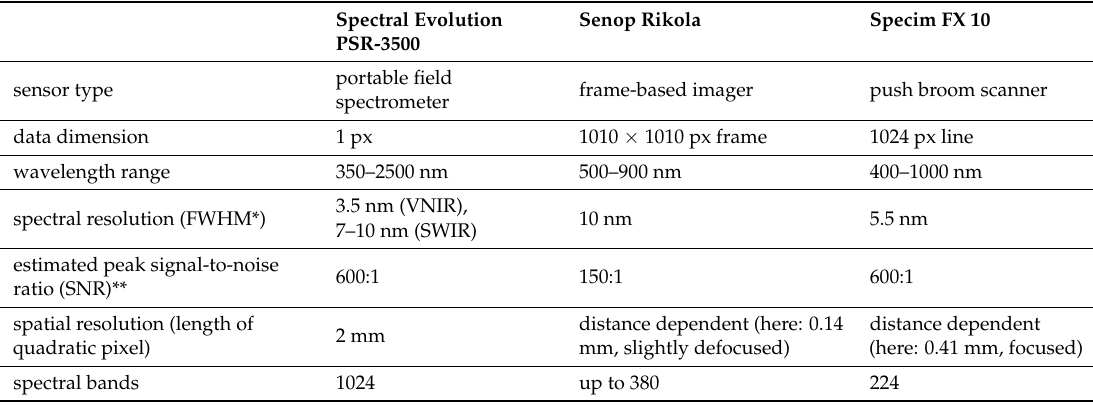
Table 2. Visible/near infrared (VNIR) HS sensor characteristics. *FWHM = full width at half maximum, **SNR values estimated for each spectral channel as ratio of mean and standard deviation of 20–40 spectra acquired under uniform conditions.